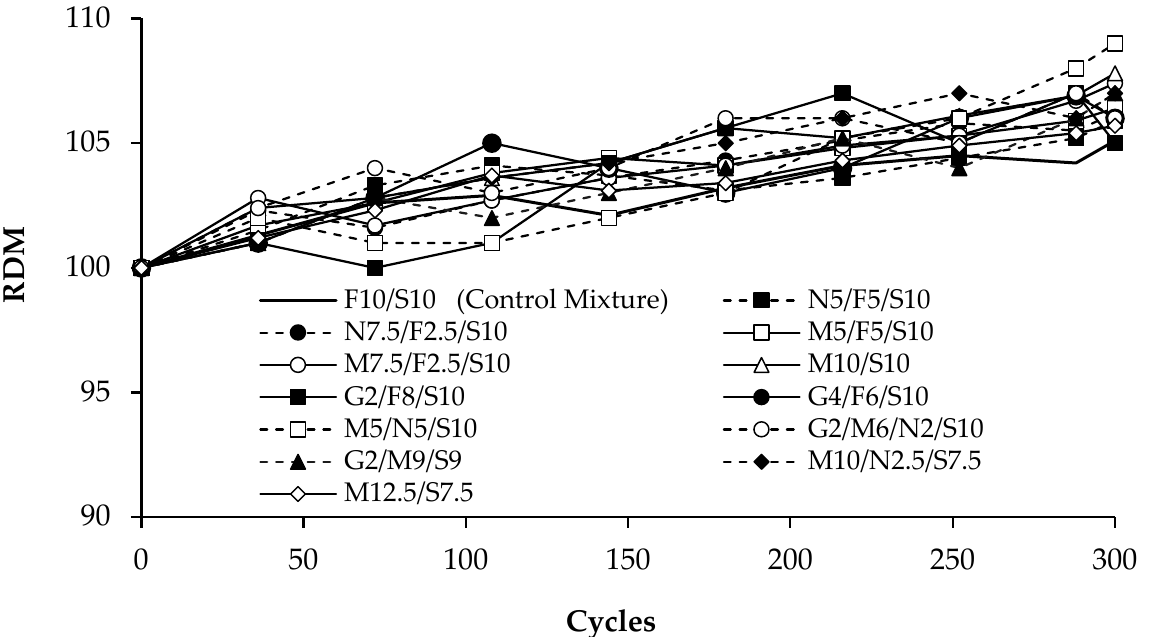
Figure 9. Freezing and thawing test results.